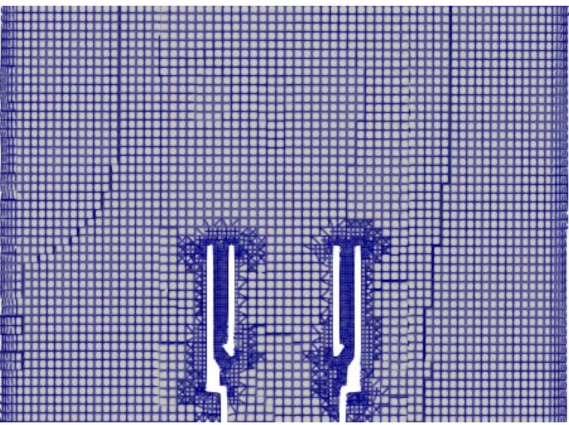
Figure 4. A portion of the mesh surrounding the burner